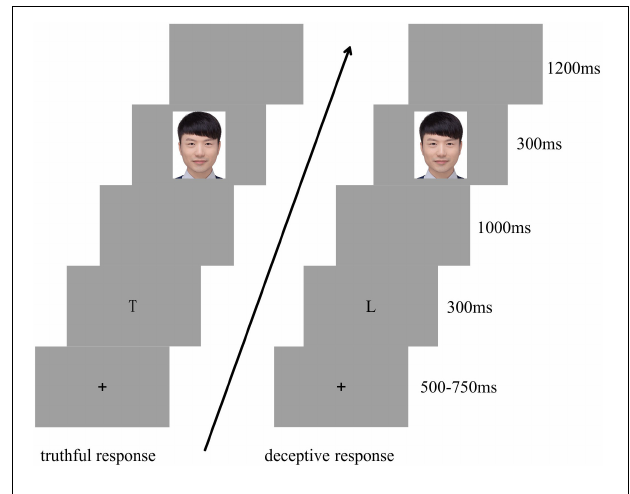
FIGURE 1 | Experiment